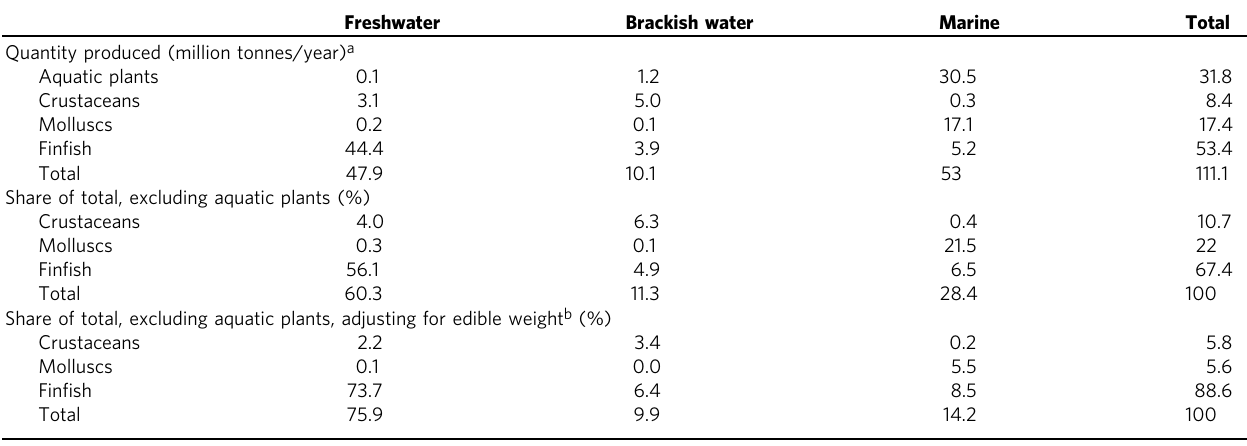
Table 3 Quantity and shares of global farmed production of aquatic organisms in freshwater, brackish water and marine environments 54